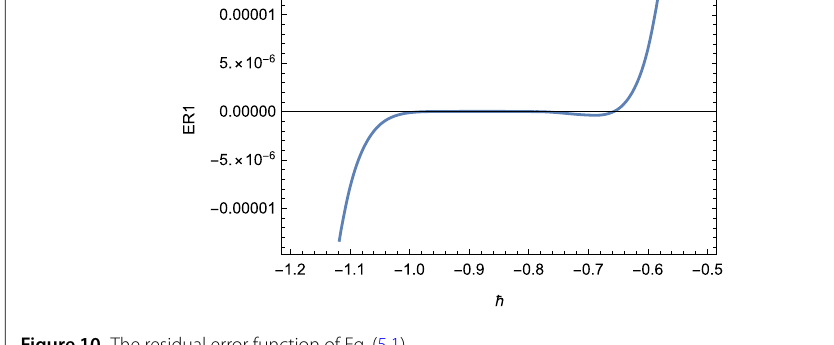
Figure 10 The residual error function of Eq.